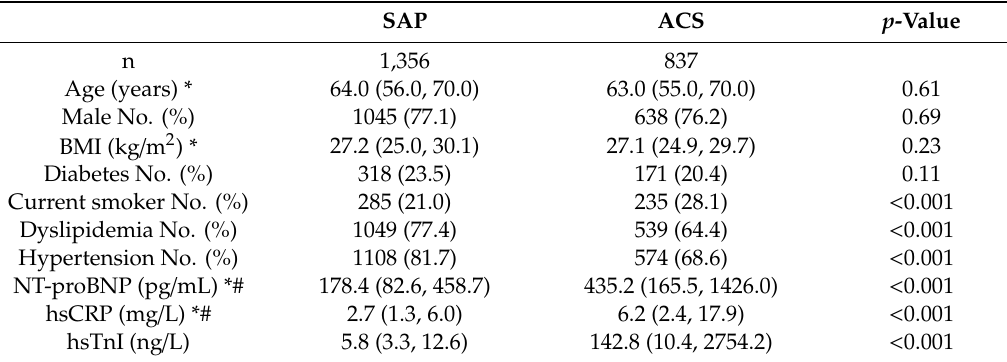
Table 1. Characteristics of the study patients with coronary heart disease. SAP